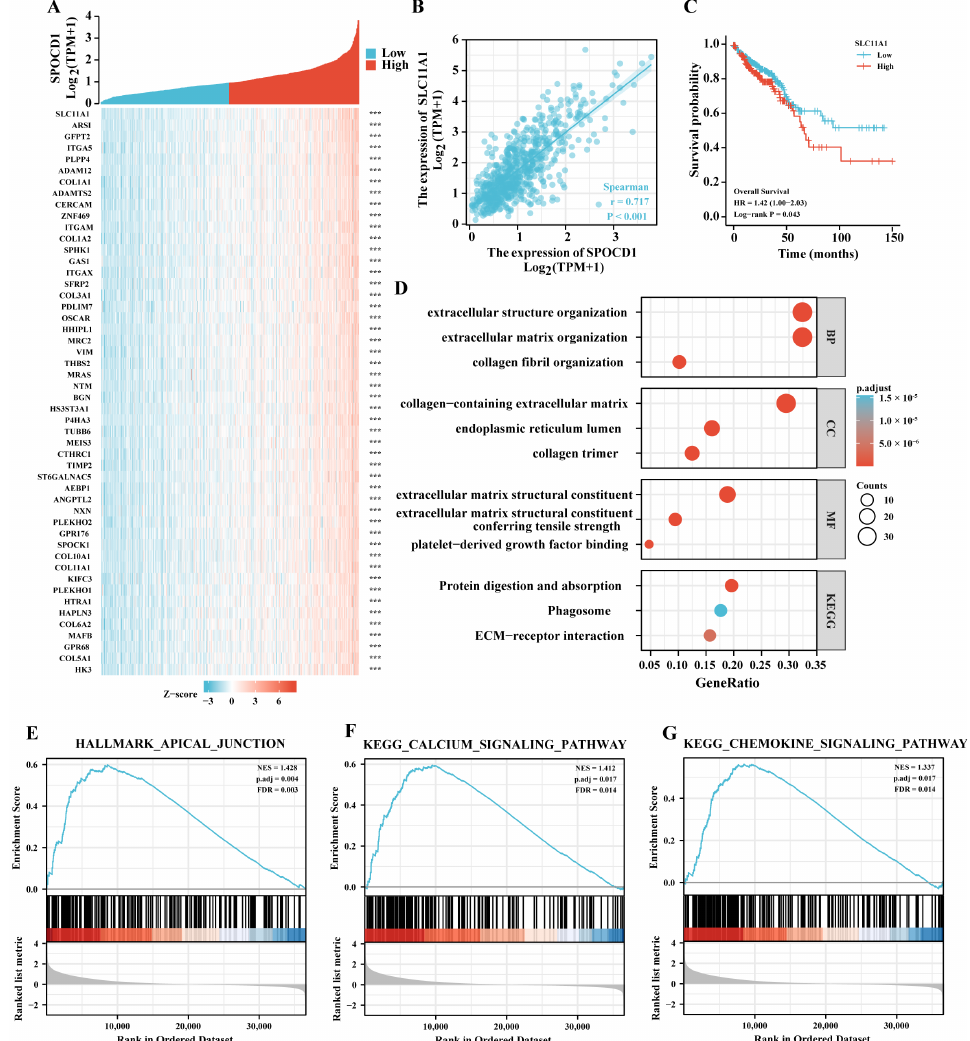
Figure 3. Co-expression gene analysis and subsequent GO and KEGG enrichment analysis of SPOCD1. ( A ) Heatmap illustrating the top 50 genes positively correlated with SPOCD1 in CRC. Red represents high expression, and blue represents low expression. ( B ) Correlation analysis of SPOCD1 and SCL11A1. ( C ) The Kaplan-Meier plots for overall survival for CRC patients according to the difference SLC11A1 expressions. ( D ) GO and KEGG pathway analysis of SPOCD1 co-expressed gene with a correlation coefficient > 0.6 in CRC. ( E – G ) GSEA enrichment plots showed positive correlations of SPOCD1 co-expression genes with the apical junction, calcium, and chemokine signaling pathway (*** p <